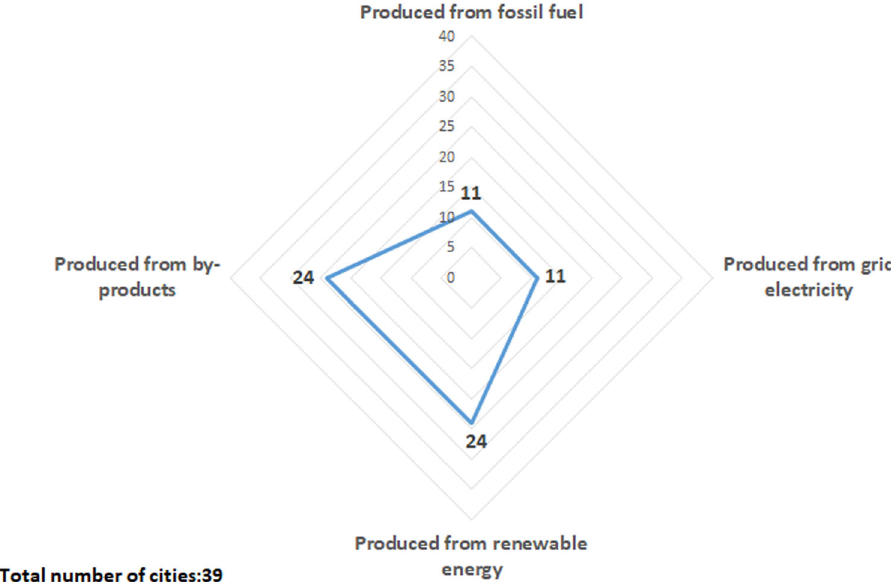
Fig. 2 Hydrogen production methods proposed in city-level policy plans by 2025. The position of data represents the number of